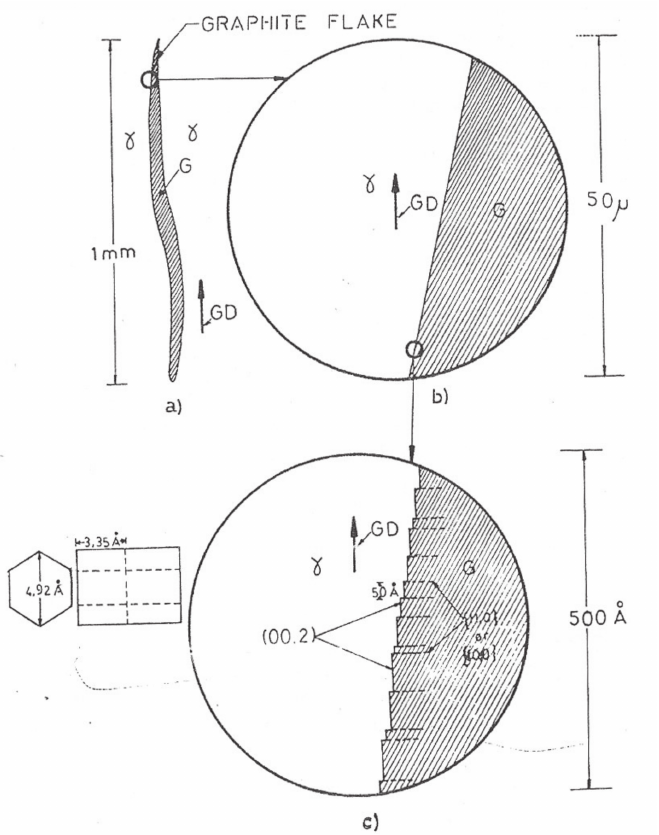
Figure 12. ( a – c ) This model shows curved basal plane of lamellar graphite (LG) growing with no-faceted interface.